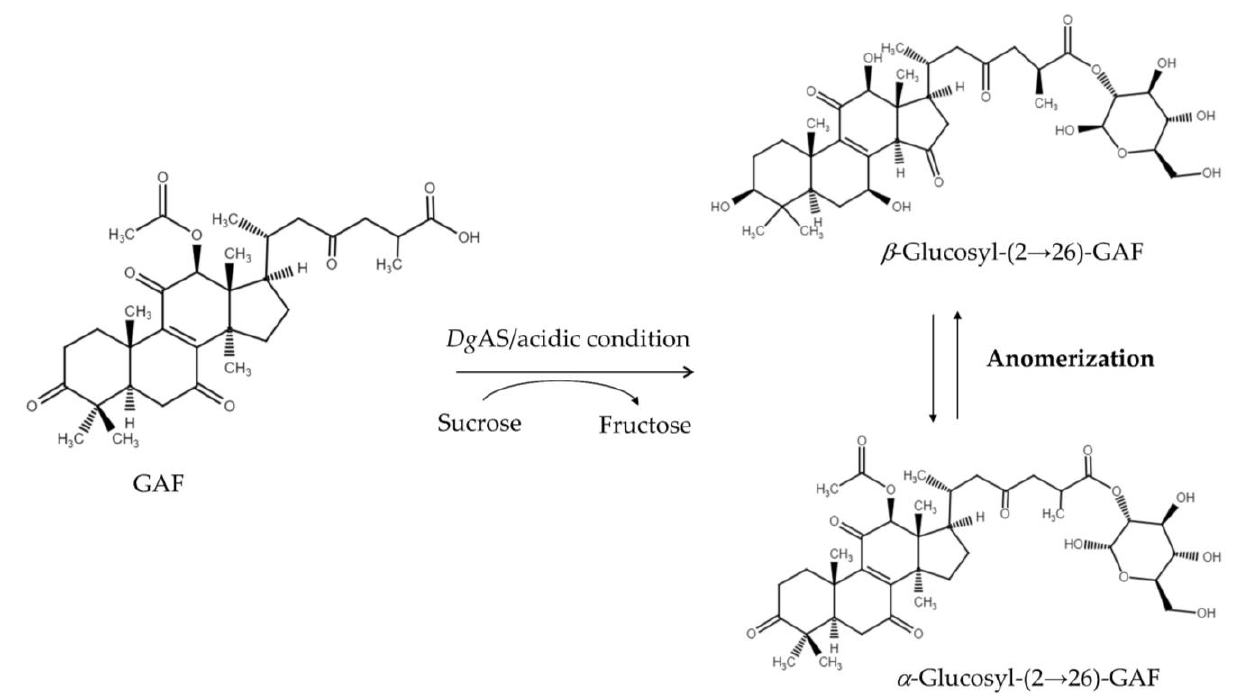
Figure 3. The biotransformation process of GAF to GAF glycoside anomers by Dg AS.